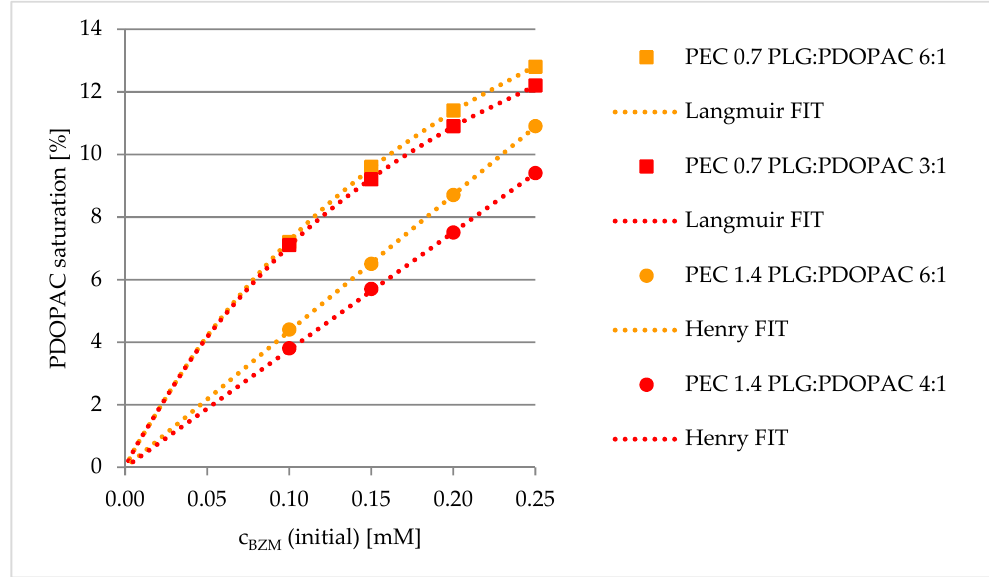
Figure 8. E ff ect of net charge (PEC 0.7, PEC 1.4) and PLG / PDOPAC ratio on PDOPAC saturation in Figure 8. Effect of net charge (PEC 0.7, PEC 1.4) and PLG/PDOPAC ratio on PDOPAC saturation in dependence of initial BZM dependence of initial BZM concentration.